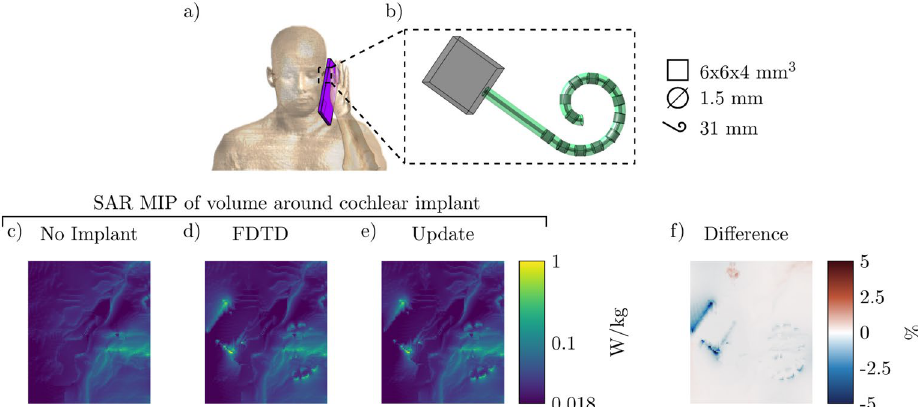
Figure 7. Proposed method applied to calculate the SAR increase for a cochlear implant when using a mobile phone. ( a ) The Ella model with a mobile telephone. The antenna is at the bottom of the phone and operates at 900 MHz. ( b ) The cochlear implant inside the Ella model. The implant has 12 electrodes and the lead is 31 mm long with a diameter of 1.5 mm. ( c ) The MIP of the local SAR without the cochlear implant. ( d ) and ( e ) The MIPs of the local SAR with the implant present using the FDTD and the proposed method respectively. ( f ) The MIPs of the difference between the FDTD and the proposed